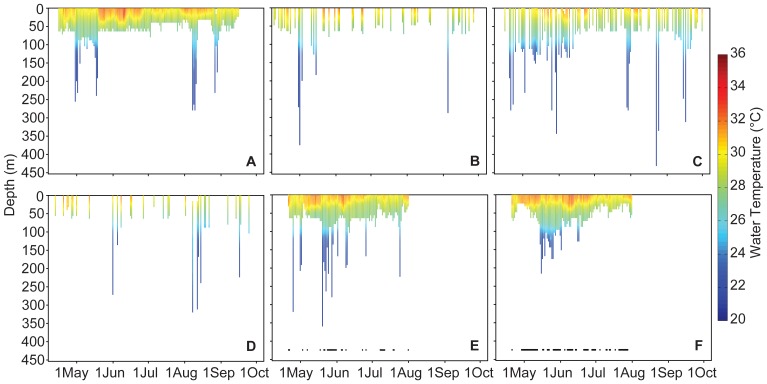
Daily ambient water temperature and depth.Daily ambient water temperature (indicated by color) and depth (y-axis) experienced by Manta alfredi for the duration of satellite tag deployment in 2011 near Al Lith, Saudi Arabia. (A) Manta identification number MA106 (B) MA102 (C) MA105 (D) MA104 (E) MA112 (F) MA111. Black points at the bottom of panels (E) and (F) indicate days for which the satellite tags resolved FastLoc GPS locations.